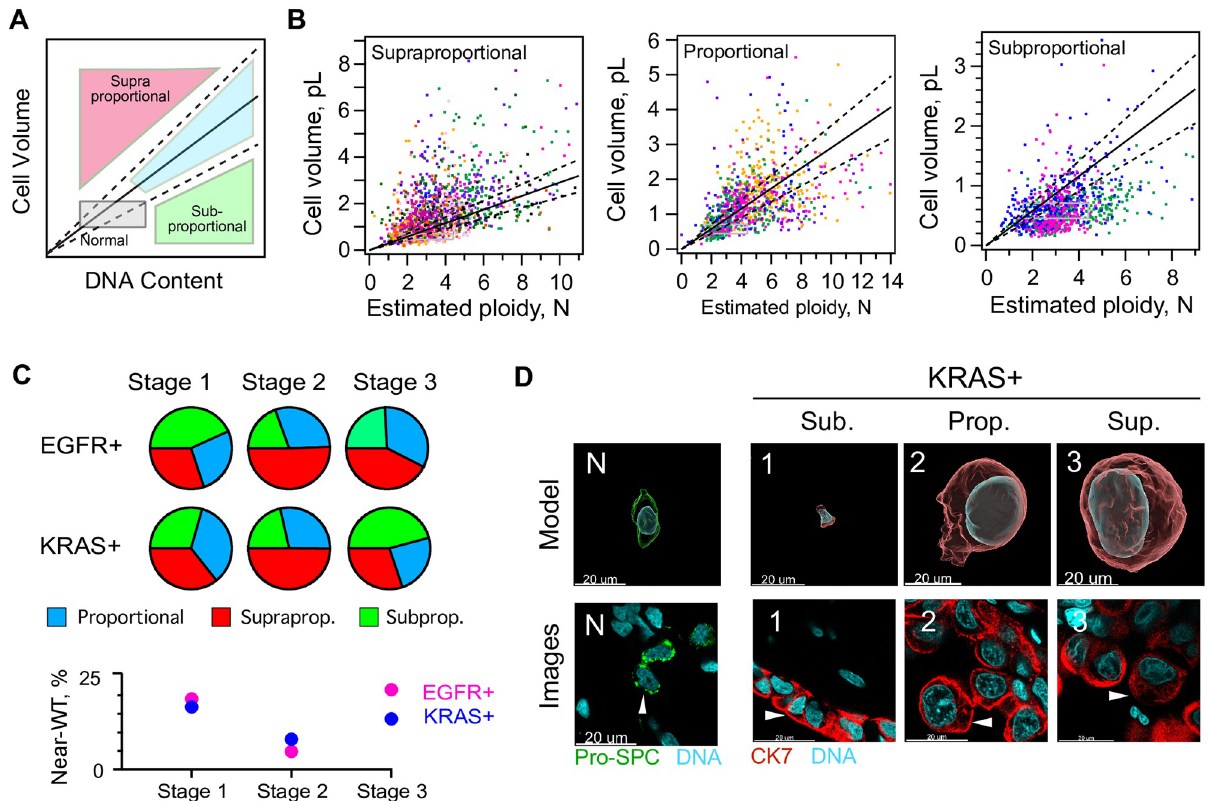
Fig 3. Ploidy alone cannot explain a majority of cell and nuclear size dysregulation. 63X images shown. A., schematic: subgroups of scaling relationships between DNA content and cell volume: supra: cell volumes larger than expected for ploidy; sub: DNA content higher than expected for cell volume. Colors, individual patient data. Grey box, near-WT, with AT2 volume μ ± σ and near-euploid (n = 1.6–4.4). B., distributions of cell ploidy and volume for individual cells; colored to distinguigh patients. Solid black line indicates simple multiplication of the estimated cell volume and ploidy of a normal AT2 cell, or the equivalent slope; showing +/- 1 S.D., dotted lines. For example, the solid passes through the point (2 x 582 fL, 2 x 2n), where 582 is the mode of the first gaussian fit to the AT2 cell volume distribution (See S6 Fig). The three plots each represent a binning of patients from all stages and both genotypes, but with either no preference, Proportional, or a departure from this line, Subproportional, or Supraproportional. C., top, the fraction of cells classified within each category of abnormal (EGFR+, N = 10, n = 2195, KRAS+, N = 11, n = 1939, S1 Data, tab E). More cells in stage 2 display the supraproportional phenotype, and subproportional cells are enriched in stage 3 KRAS+ cancer. C., bottom, Near-WT, cells with cell volumes close to WT (455–709 fL) that are also near-euploid (1.6–4.4n) are rare in LA, but are depleted in stage 2. Magenta, EGFR+, Blue, KRAS +. D., images of high-quality KRAS+ cell models for each representative category, right, with corresponding 2D images; N, typical AT2 controls. 1, subproportional, 2 proportional, 3 subproportional. White arrows, cells corresponding to models seen in 3D renderings. Scale bar, 20 μ